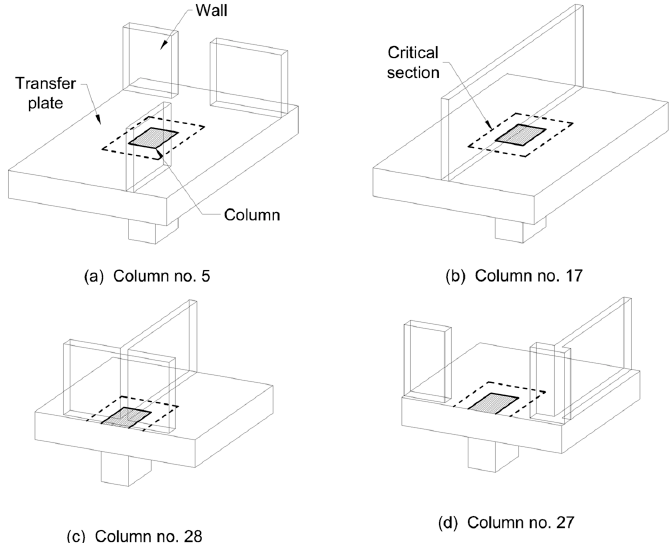
Figure 12. Example of column with / without shear wall within the critical section in L-shape plan. ( a ) Column no. 5, ( b ) Column no. 17, ( c ) Column no. 28 and ( d ) Column no. 27.